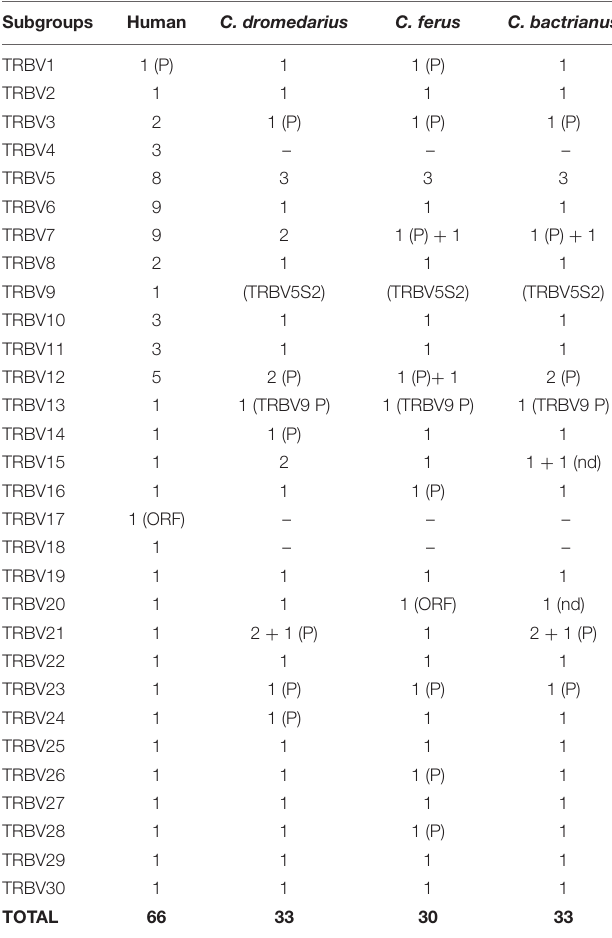
TABLE 1 | Correspondence between camel and human TRBV subgroup genes. Subgroups